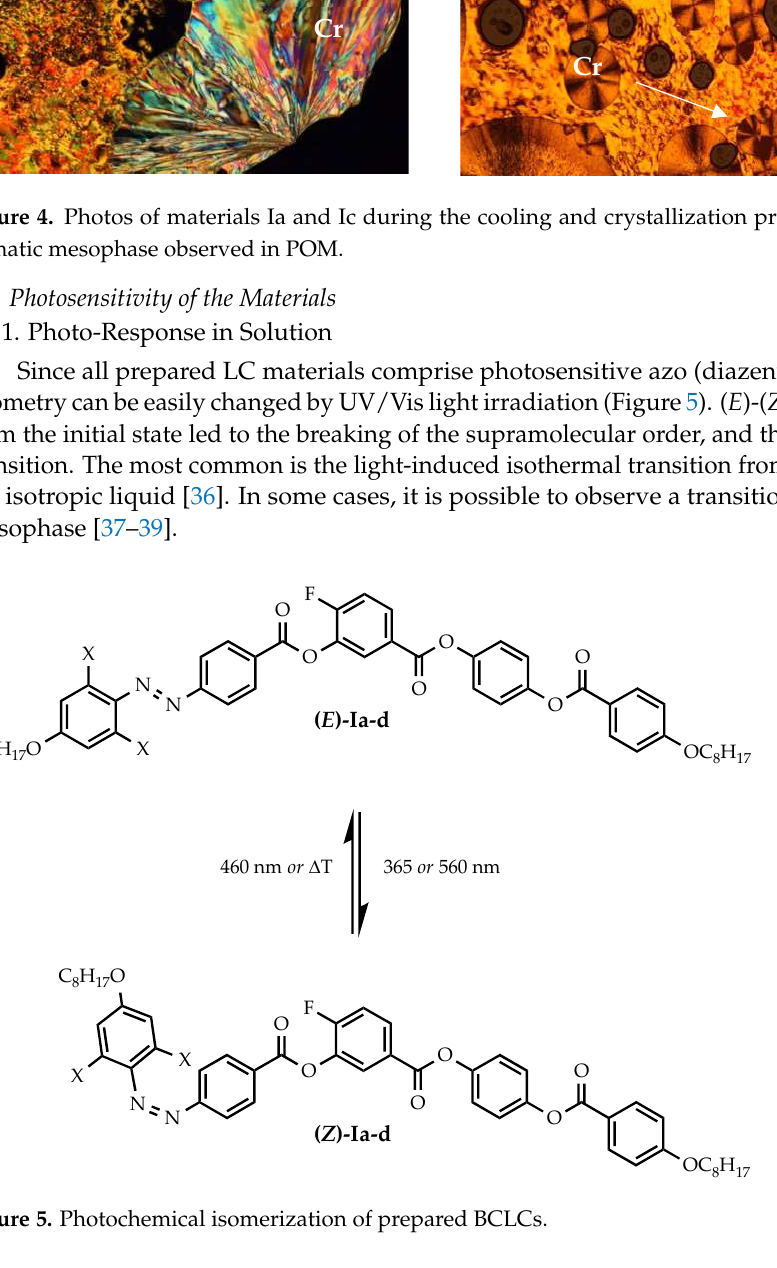
Figure 3. DSC plot of final material Id (heating—red line, cooling—blue line). The enthalpy change corresponding to the phase transition from the isotropic state to the nematic phase is shown in the inset.